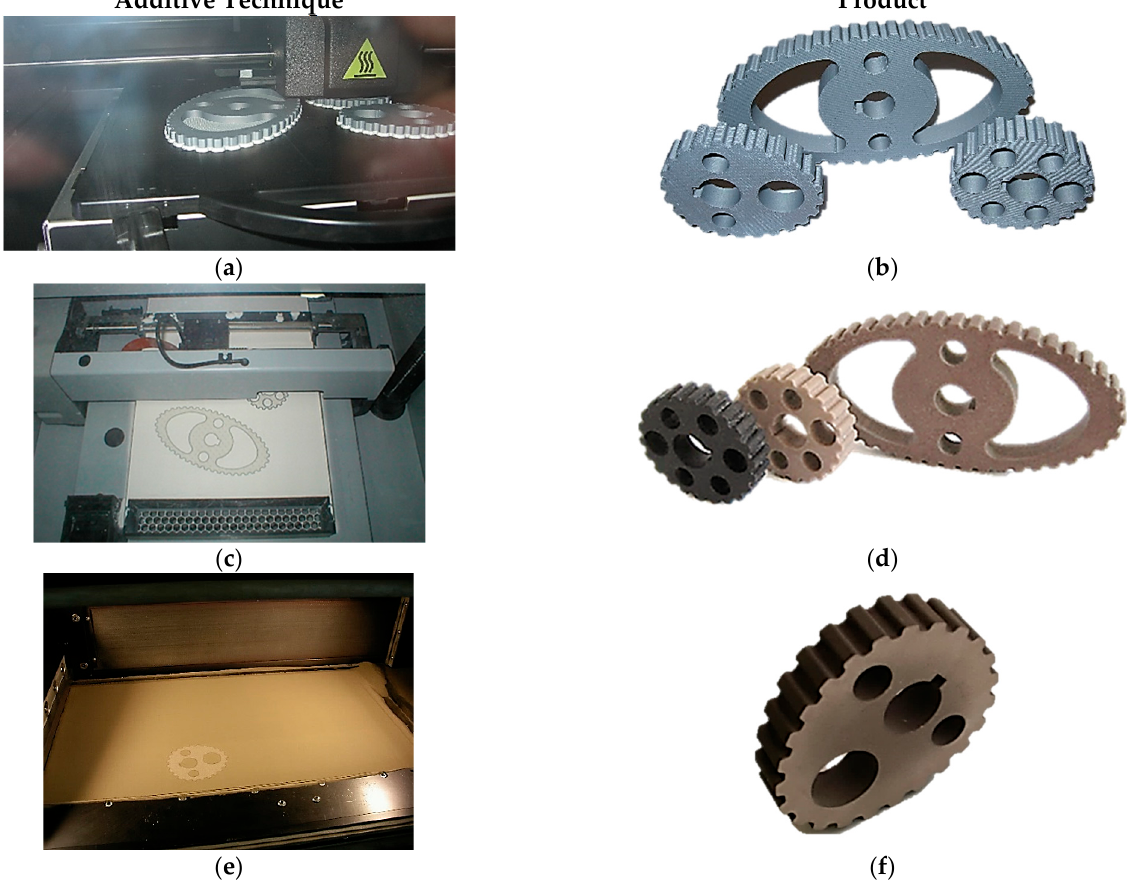
Figure 4. RP techniques employed in the experiment: ( a ) shaping process of non-circular belt pulleys shaped with FDM method, ( b ) Non-circular belt pulleys shaped out with FDM method ABS, ( c ) shaping process of non-circular belt pulleys with 3D printing methods, ( d ) Non-circular belt pulleys shaped with Z Printer 450 method (Zp 130), ( e ) Shaping process of non-circular belt pulleys with SLS method, ( f ) non-circular belt pulleys formed with SLS method after centrifugal blasting (DirectMetal20).